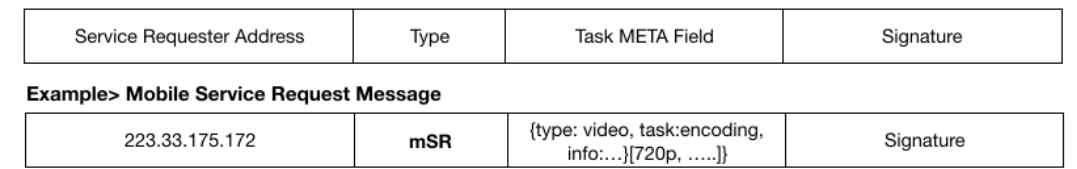
Figure 7. The mobile service request (mSR) message format and example.